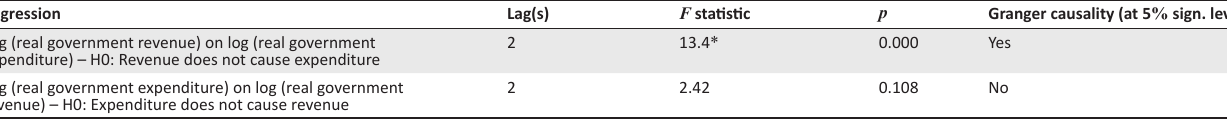
TABLE 10: Engle-Granger causality test results. Regression